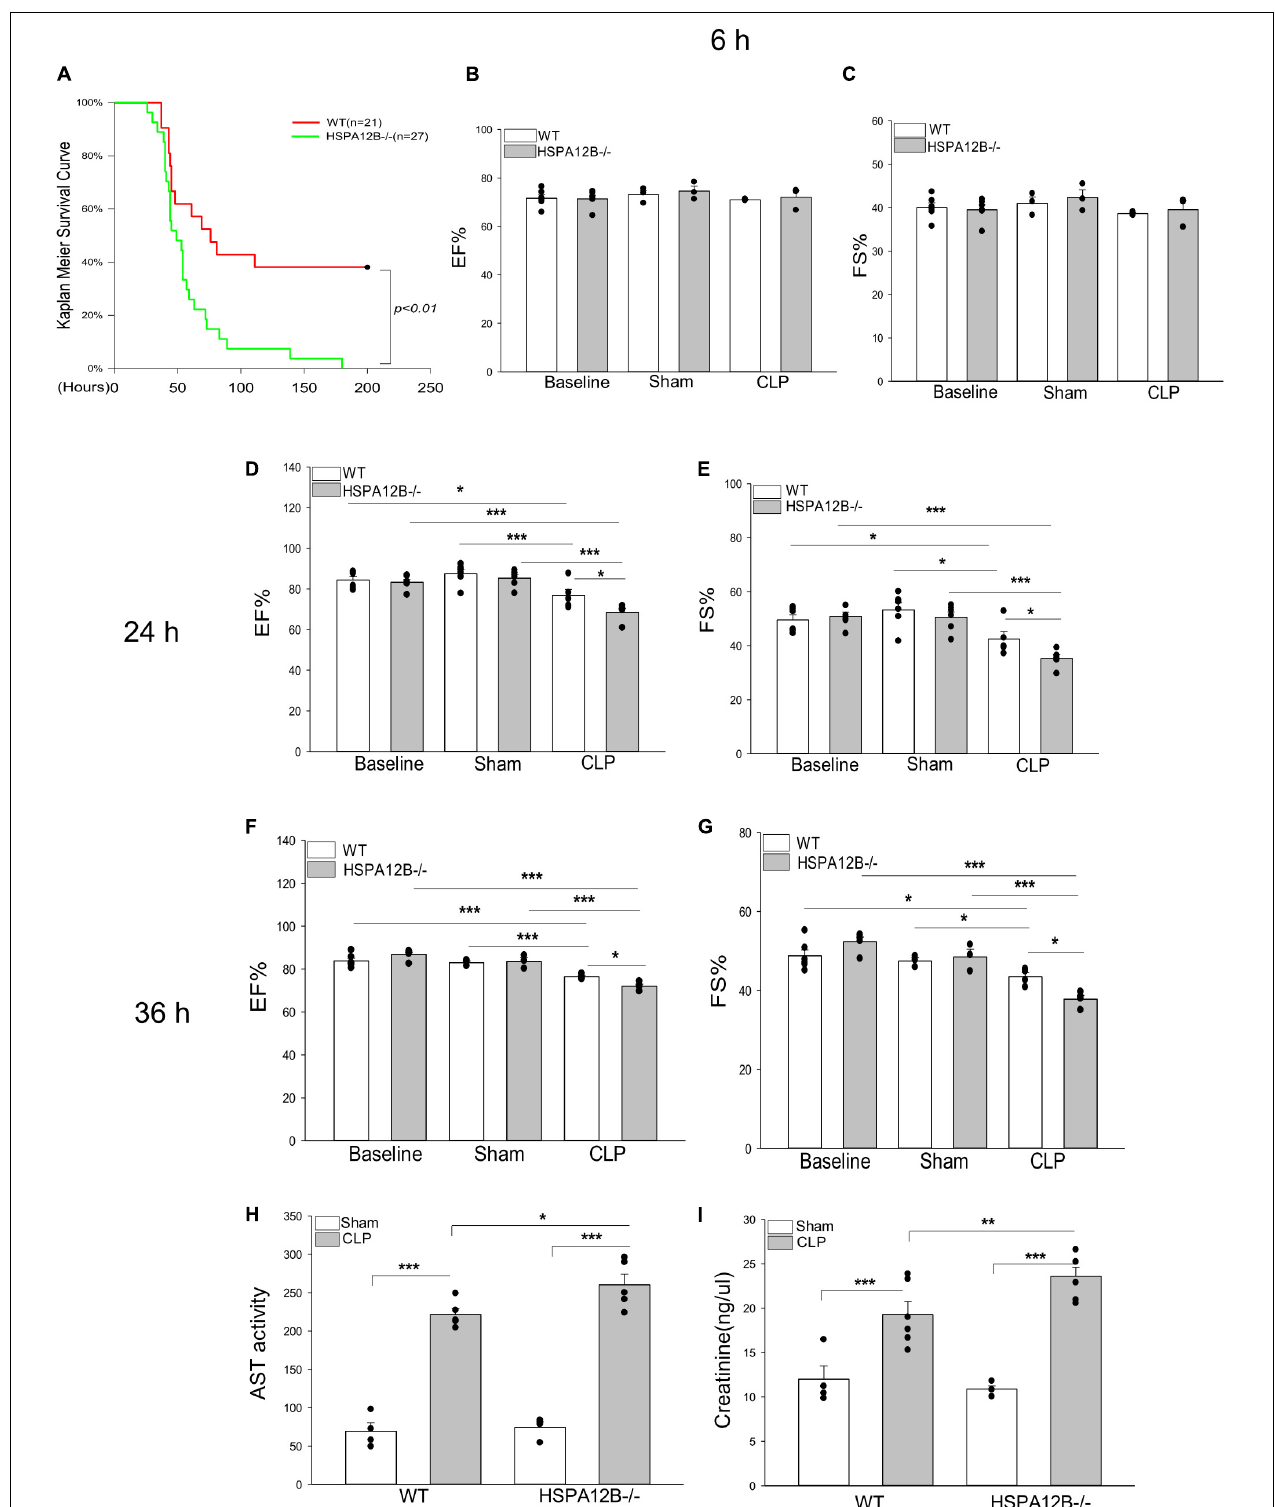
FIGURE 1 | Increased mortality and severer cardiac dysfunction in HSPA12B − / − septic mice. (A) WT and HSPA12B − / − mice were subjected to a CLP sepsis. The survival outcome was monitored for up to 200 h following induction of CLP ( n = 13 ∼ 14/group). (B–G) Cardiac function was examined by echocardiography at 6, 24, and 36 h after CLP. EF%, ejection fraction. %FS, fractional shortening. Serum levels of aspartate aminotransferase (AST; H ), creatinine (I) were measured by commercially available ELISA kits. n = 3 ∼ 6/group. * P < 0.05, ** P < 0.01, and *** P < 0.001 compared with indicated groups.